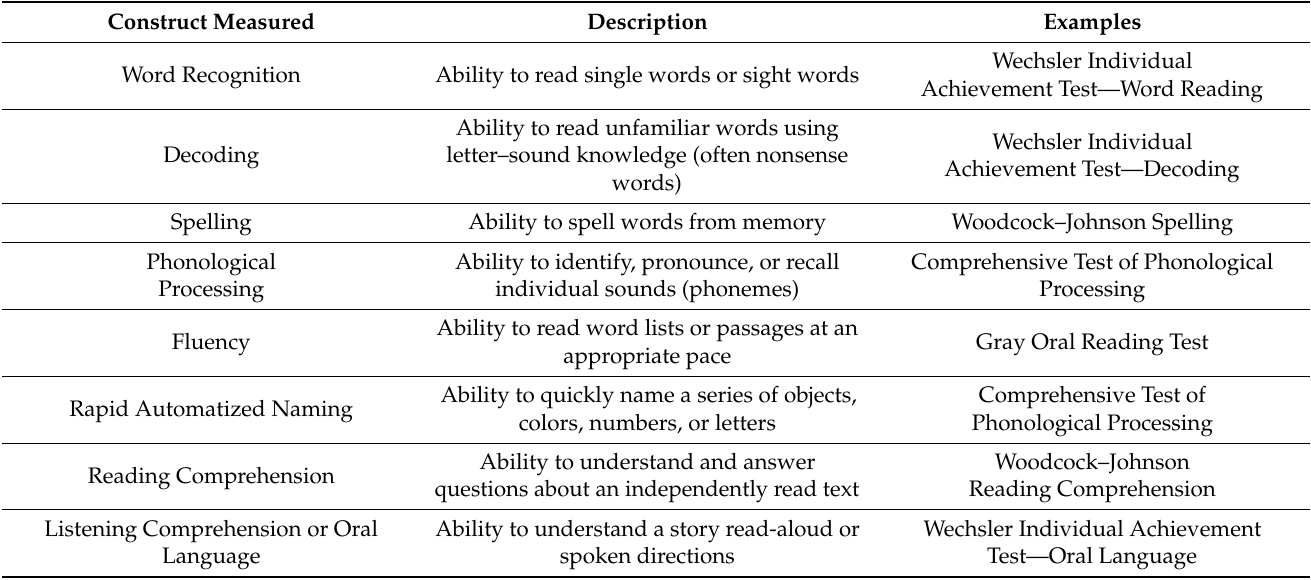
Table 1. Assessments commonly used in identifying dyslexia